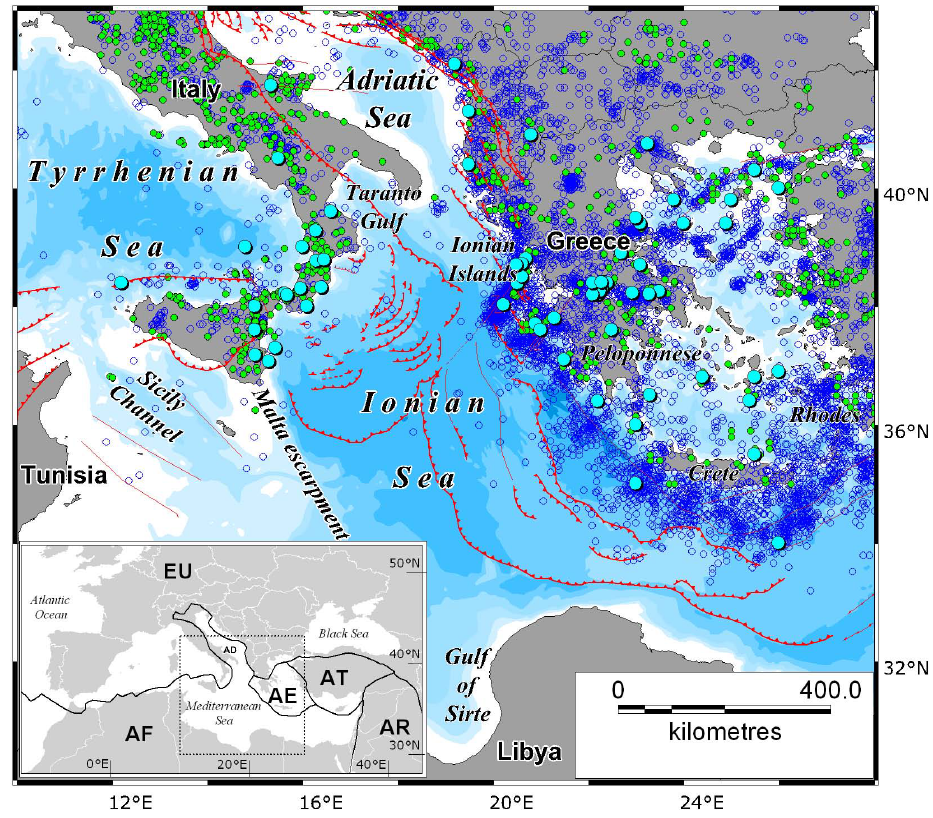
Fig. 1. Map of the study area showing the main tectonic structures (red lines represent faults; saw-toothed red lines represent thrust faults), seismicity from SHEEC (green solid circles; data from Stucchi et al., 2012) and EMEC (blue open circles; data from Gr¨unthal and Wahlstr¨om, 2012), and tsunami sources (light-blue large solid circles) from NGDC/WDS Global Historical Tsunami Database. Inset shows the general tectonic setting of the central Mediterranean Sea. Legend for tectonic plates: EU, Eurasian; AF, African; AE, Aegean; AT, Anatolian; AR, Arabian. Notice the Adria Microplate (AD), a promontory of the African Plate, which acts as an indenter in between the Apennines to the west, the Alps to the north, and the Albanides–Dinarides to the east, all facing the Adriatic Sea. Table 1. Summary of modelling approaches for crustal and subduction